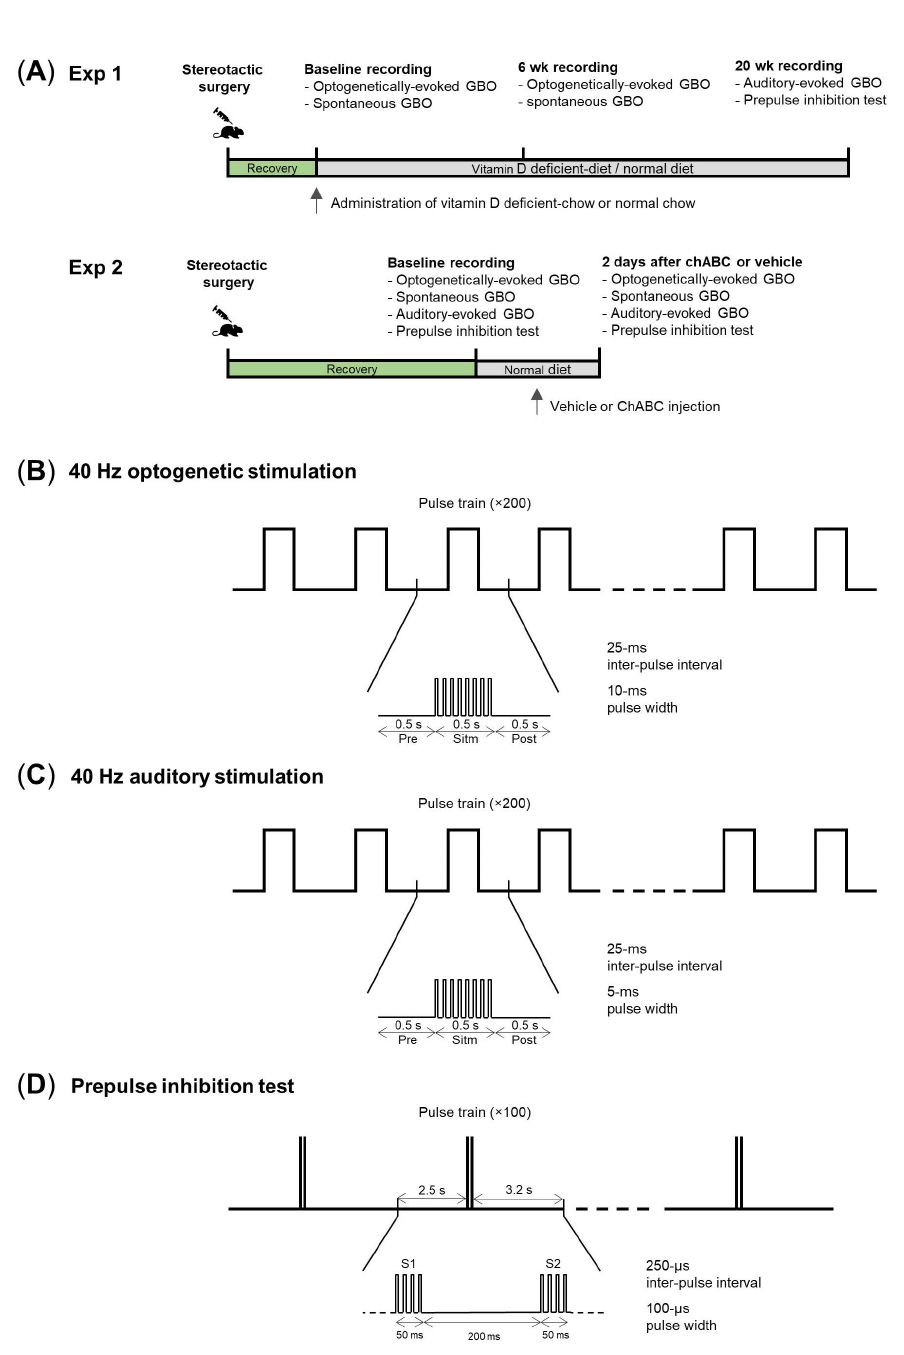
Figure 1. Scheme of the experimental schedules and the various methods for measuring frontal gamma- band oscillations (GBO). ( A ) Experimental timeline of the vitamin D-deficient diet group vs. normal diet group (VDD vs. ND, top) and the chondroitinase ABC-injected group vs. vehicle-injected group (ChABC vs. vehicle, bottom). ( B) Stimulation protocol for 40 Hz optogenetically-evoked GBO. One trial was composed of pre-stimulation, stimulation, and post-stimulation (0.5 s each). During stimulation, a pulse occurs every 25 ms, and each pulse had a duration of 10 ms. A total of 200 trains were averaged and used for the power spectrum analysis. ( C ) Stimulation protocol for 40 Hz auditory-evoked GBO. The same protocol as for the optogenetically-evoked GBO was followed, except that each pulse had a duration of 5 ms. The sound was delivered with a sound pressure of 90 dB. ( D ) Stimulation protocol for the prepulse inhibition test. One train composed of two pulses (S1, S2) and 100 trains were averaged and used for power spectrum analysis. Each pulse continued for 50 ms, and a 5 kHz sound was delivered with 90 dB (6 s inter-trial interval, ITI; 250 ms inter-pulse interval,